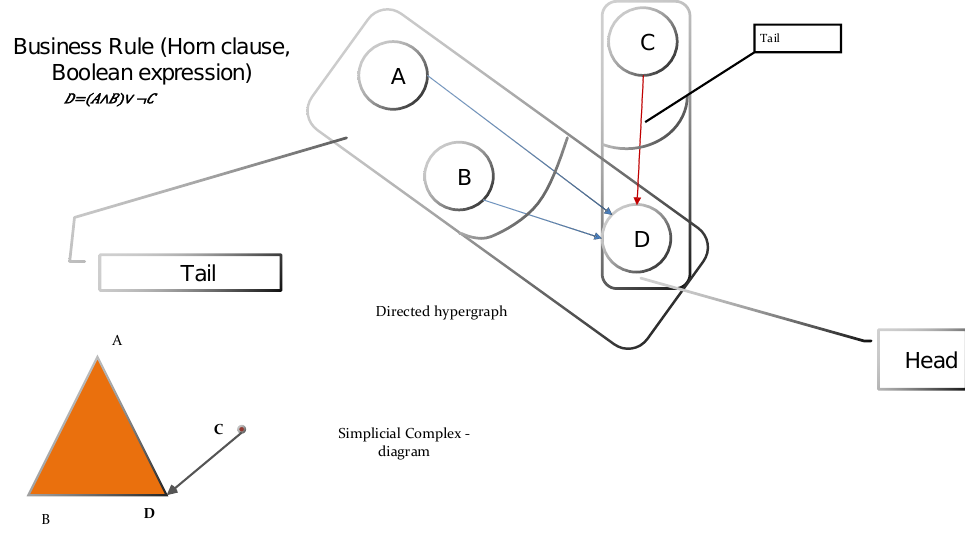
Figure 11. Business Rules: logical